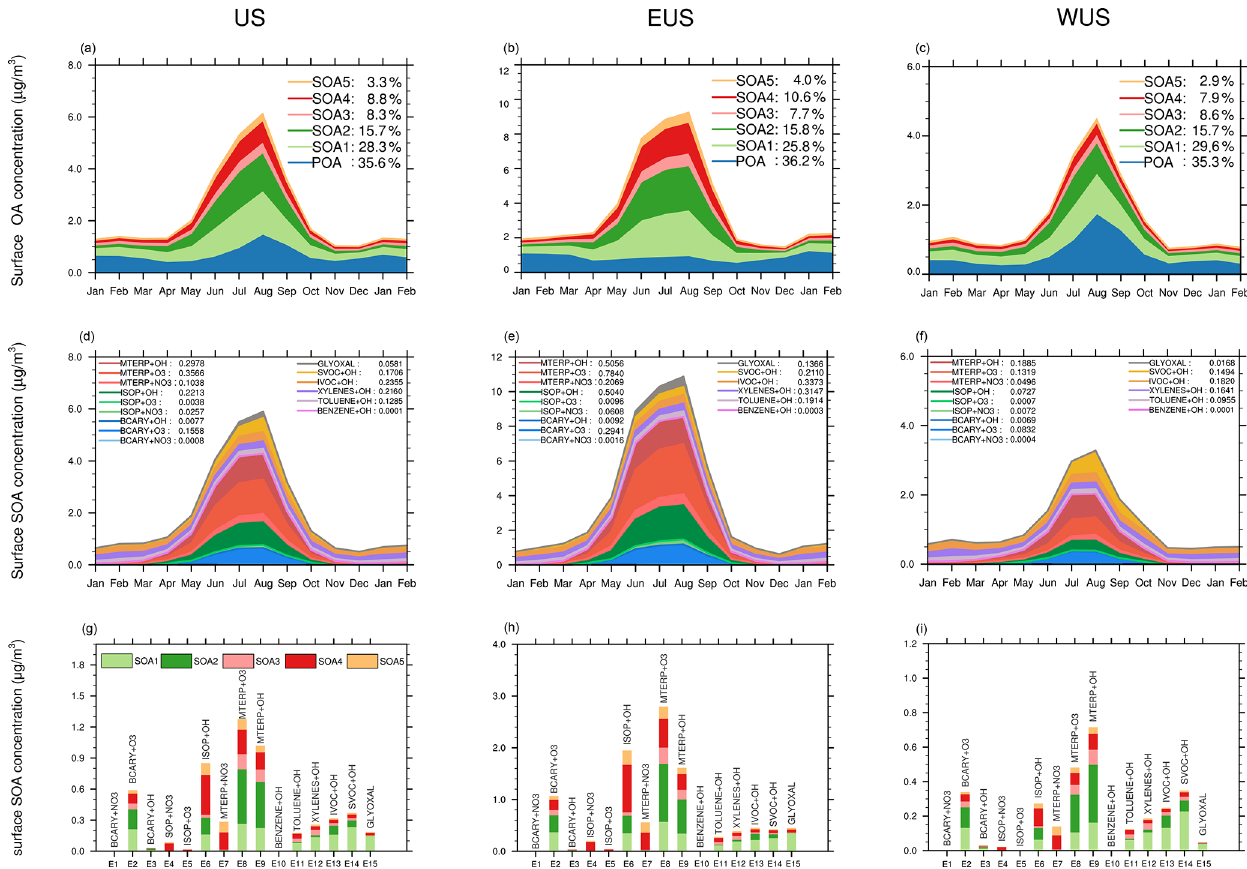
Figure 4. (a) – (c) Seasonal variation in surface OA concentrations from CAM-Chem-climo simulation at all IMPROVE sites located over (a) CONUS, (b) EUS, and (c) WUS. The contributions of POA and SOA in five VBS bins are shown in filled areas. The 14-month average contribution of POA and SOA are shown as the number in the legend. (d)–(f) Seasonal variation of SOA formed by 15 different pathways over (d) CONUS, (e) EUS, and (f) WUS. The contribution of 15 reactions are shown in filled areas, and the 14-month average contribution is shown as the number in the legend. (g)–(i) The contributions from each pathway to the five SOA bins over (g) CONUS, (h) EUS, and (i) WUS in July 2010. The SOA concentrations in five bins are shown in filled